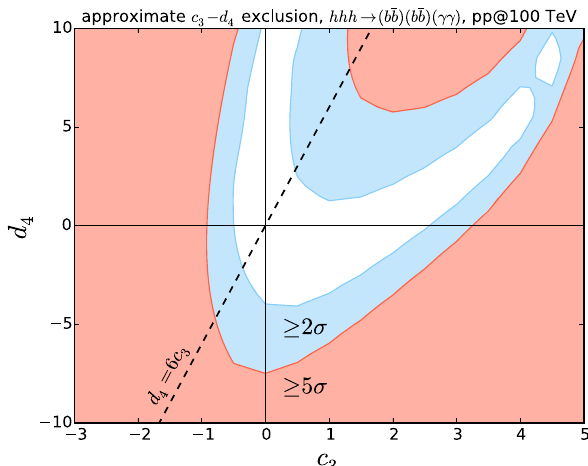
Fig. 10.10 The approximate expected 2 σ (blue) and 5 σ (red) exclusion regions on the c 3 − d 4 plane after 30 ab − 1 of integrated luminosity